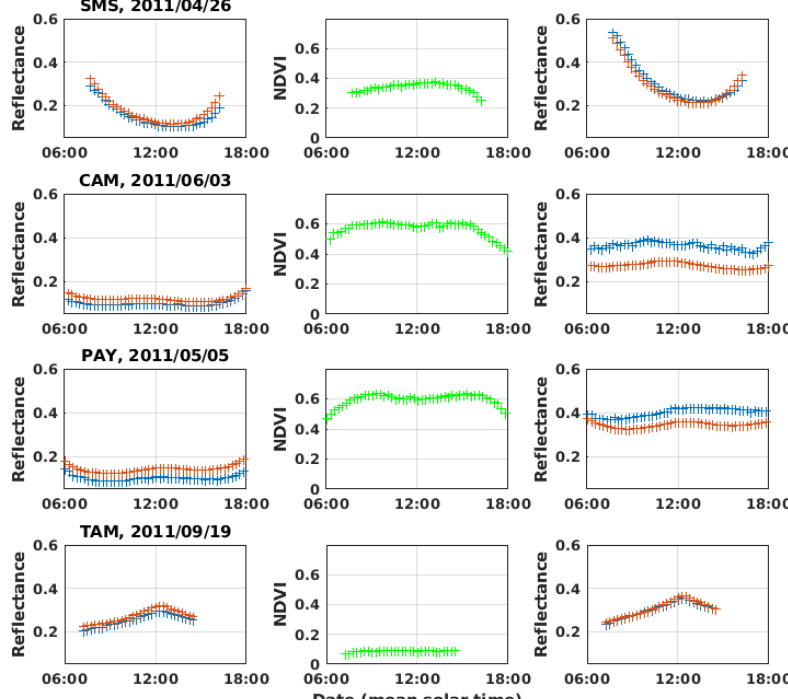
Figure B4. Comparison between simulated (red plus signs) and measured reflectances (blue plus signs) at the top of the atmosphere for 1d in clear-sky conditions, for the 0.6µm (first column) and 0.8µm channels (third column). NDVI computed from satellite measurements is shown in the second column. Rows from top to bottom: locations of the São Martinho Da Serra, Camborne, Payerne, and Tamanrasset BSRN